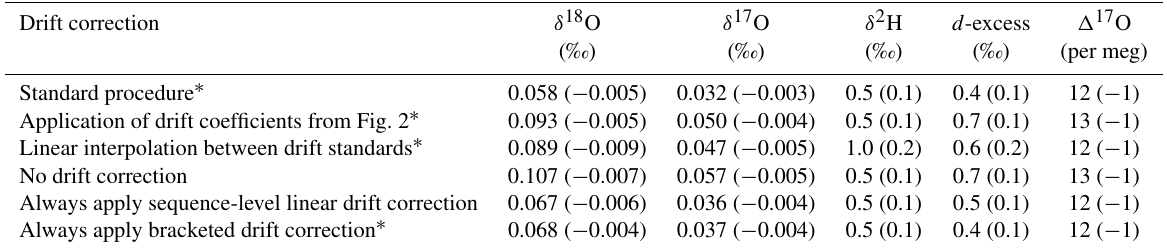
Figure 2. Histograms of ordinary least-squares regression slopes of drift standard isotope values versus elapsed sequence time. Summary statistics are presented above each plot. The 95% confidence intervals are the 2.5 and 97.5 percentiles of the bootstrapped distribution of mean slopes. Table 4. Accuracy metrics for all control and drift vials of known isotope composition for various drift-correction approaches. Values for root mean square error (RMSE) and mean signed difference (MSD; in parentheses) for all vials analyzed during the ∼ 2 year measurement